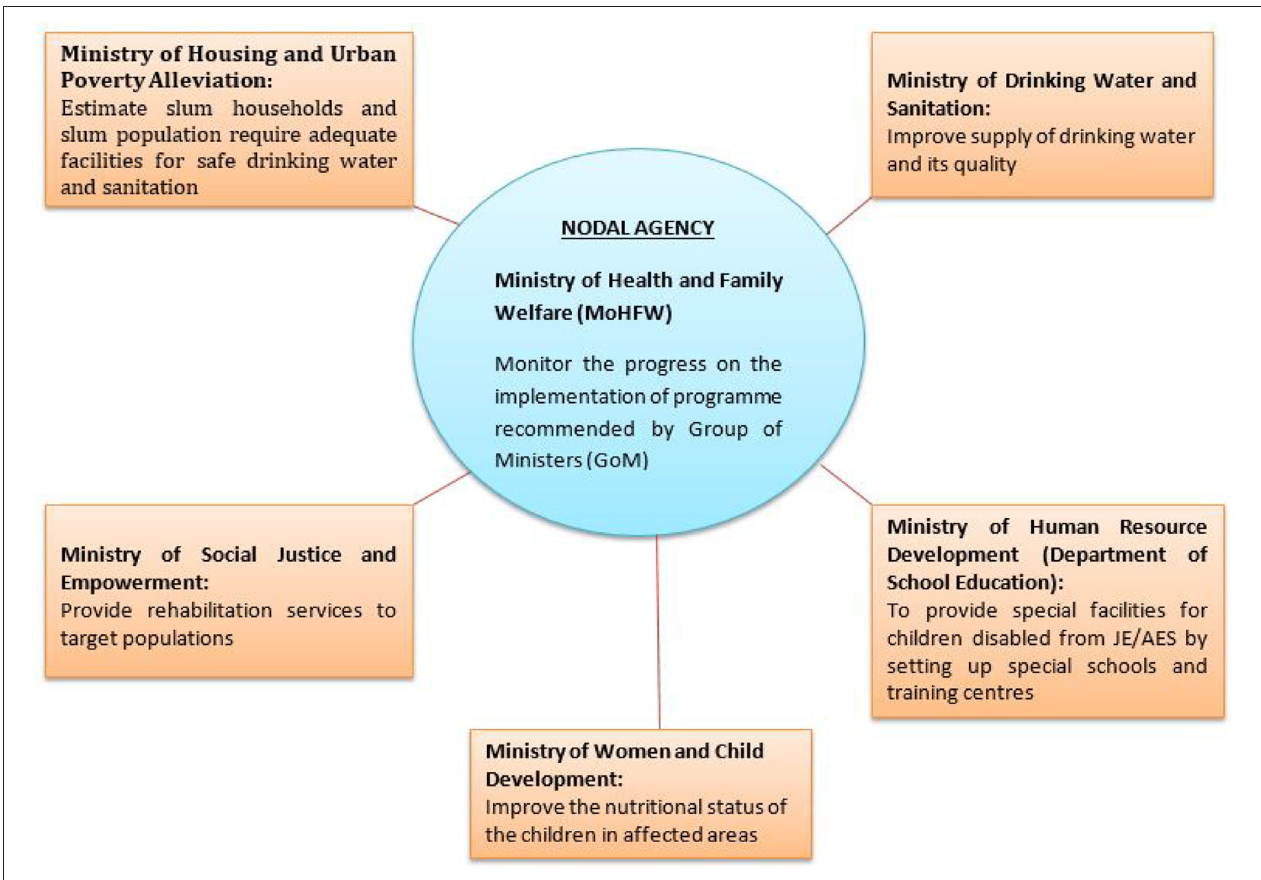
FIGURE 1 | Convergence of five ministries/departments to resolve complexities involved in the implementation of national programme for prevention and control of JE/AES.